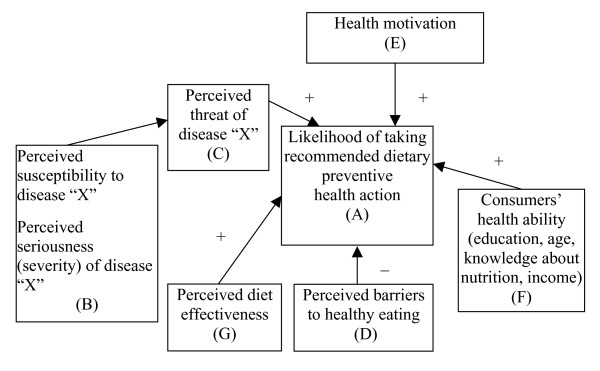
The Romanian Dietary Health Preventive Behaviour Model. Source: Adapted and extended from [11] and [12].